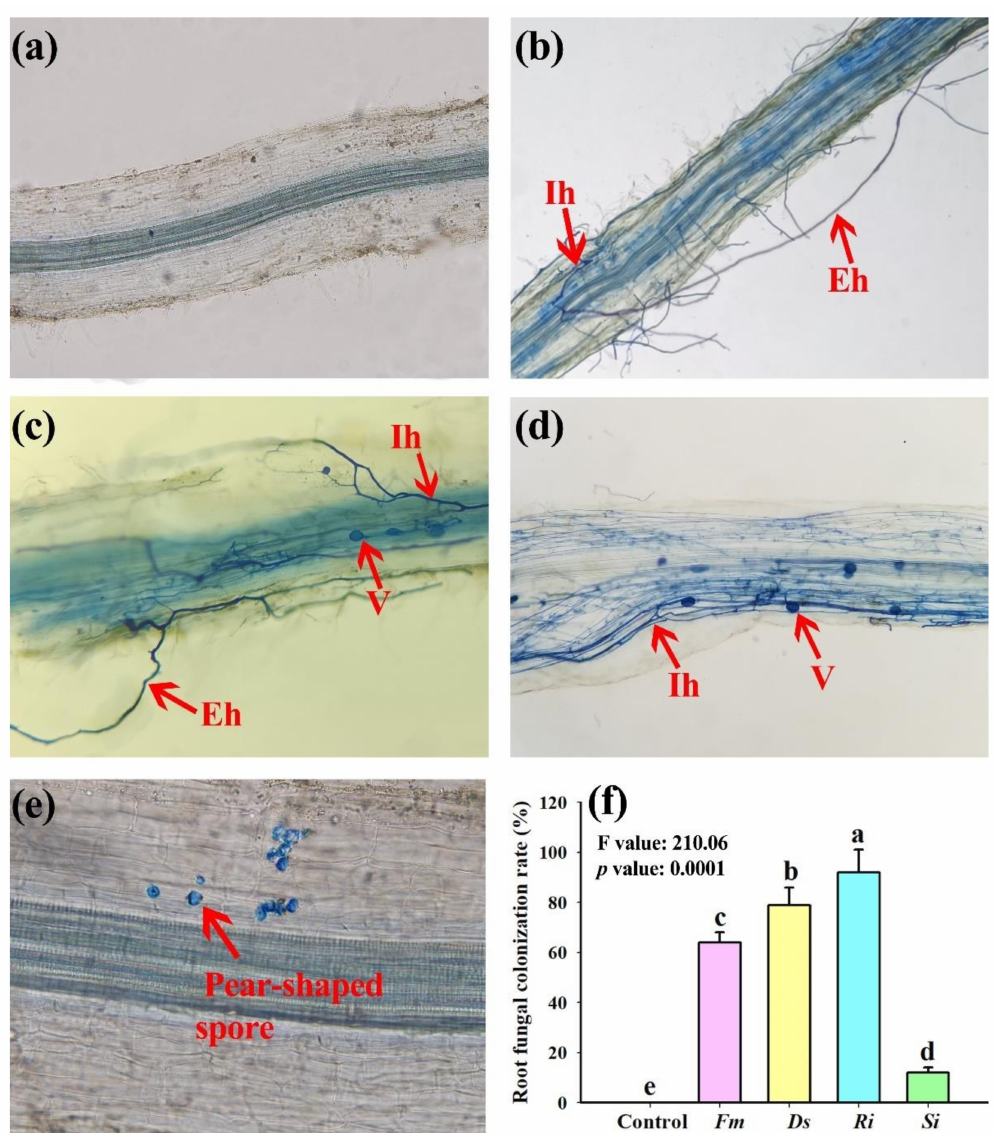
Figure 1. Root fungal colonization of Vicia villosa plants and changes in root fungal colonization rate after inoculation with four symbiotic fungi. Data (means ± SD, n = 4) followed by different letters above the bars indicate significant ( p < 0.05) differences. ( a ): no fungal colonization in the control roots; ( b ): fungal colonization in Fm -inoculated roots; ( c ): fungal colonization in Ds -inoculated roots; ( d ): fungal colonization in Ri -inoculated roots; ( e ) fungal colonization in Si -inoculated roots; ( f ) changes in root fungal colonization rate. Abbreviations: control, no-fungi inoculation; Ds , Diversis- pora spurca ; Eh, extraradical hyphae; Fm , Funneliformis mosseae ; Ih, intraradical hyphae; Si , Serendipita indica ; Ri , Rhizophagus intraradices ; V,